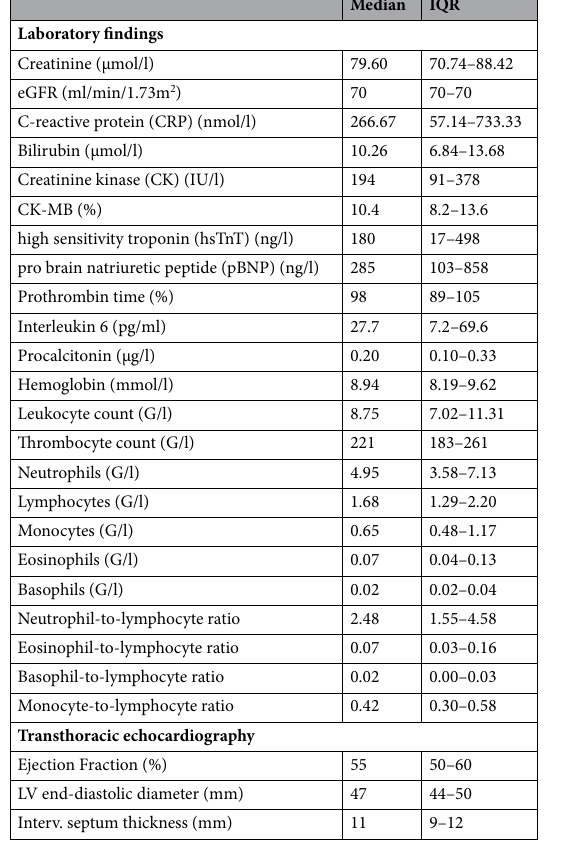
Table 2. Laboratory findings. Abbreviations: IQR = interquartile range, eGFR = estimated glomerular filtration rate, CK-MB = creatinine kinase muscle-brain